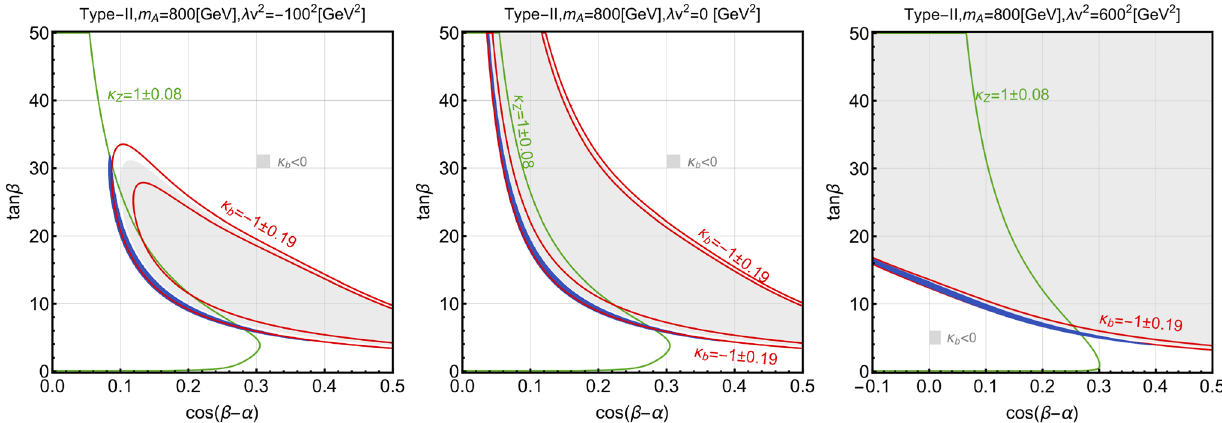
Fig. 4 The blue allowed region in the plane of tan β - cos (β − α) at 95% C.L. for Type-II 2HDM, given LHC Run-II Higgs precision mea- surements at one-loop level. Here we take the benchmark parameters m A = m H = m H ± = 800 GeV, λv 2 = − 100 2 (left), 0 (middle), abd